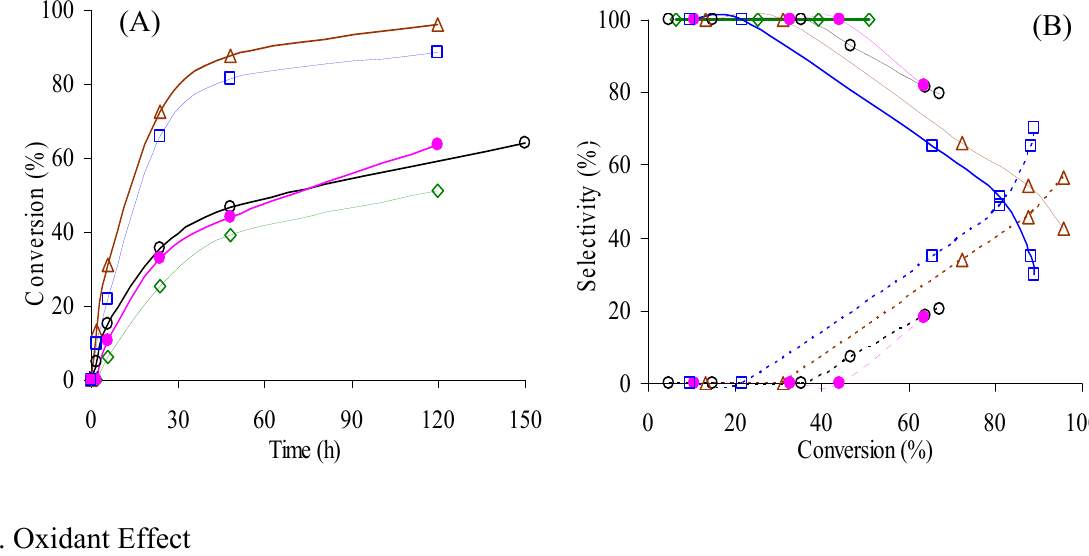
Figure 4. (A) - Ethylbenzene oxidation with t -BuOOH, in the presence of CeNR, at 55 ºC ( (cid:145) ), 70 ºC (run 1 - ( O ); run 2 - ( (cid:122) )), 90 ºC ( (cid:85) ), 105 ºC ( (cid:133) ), using acetonitrile as solvent. (B) - Dependence of selectivity to PhEtOOT (solid lines) and acetophenone (dashed lines) on conversion for the reactions conditions indicated in (A) - the same symbols were used for each